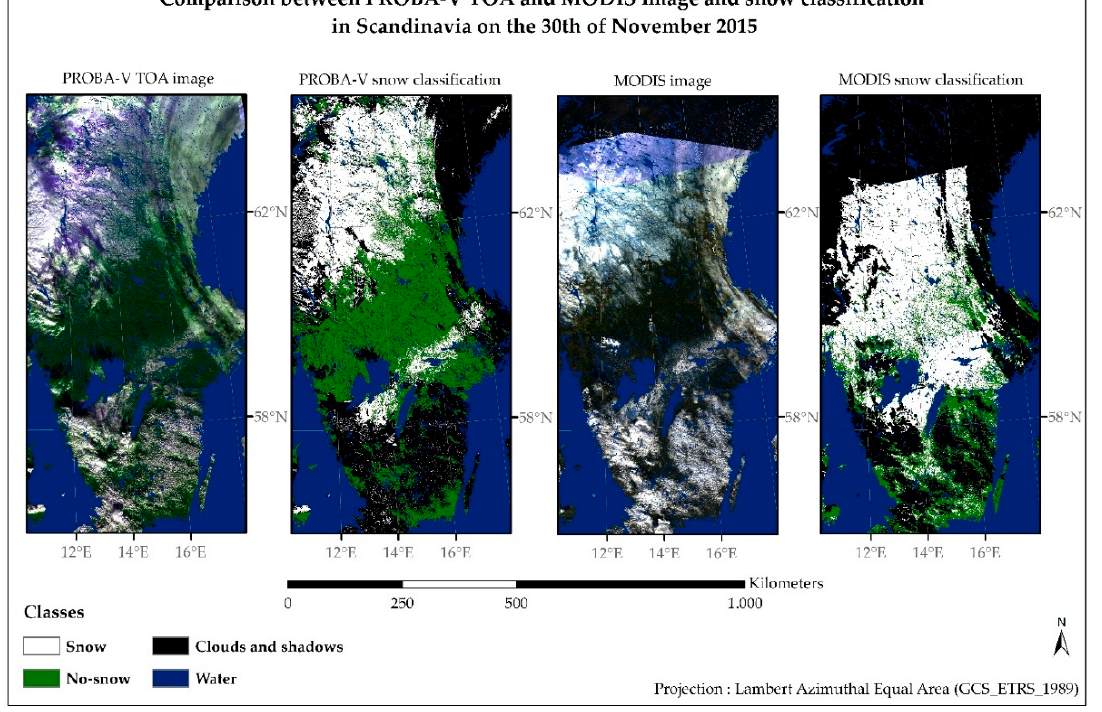
Figure 7. Comparison between a PROBA-V true color image and a MODIS image of a part of Scandinavia